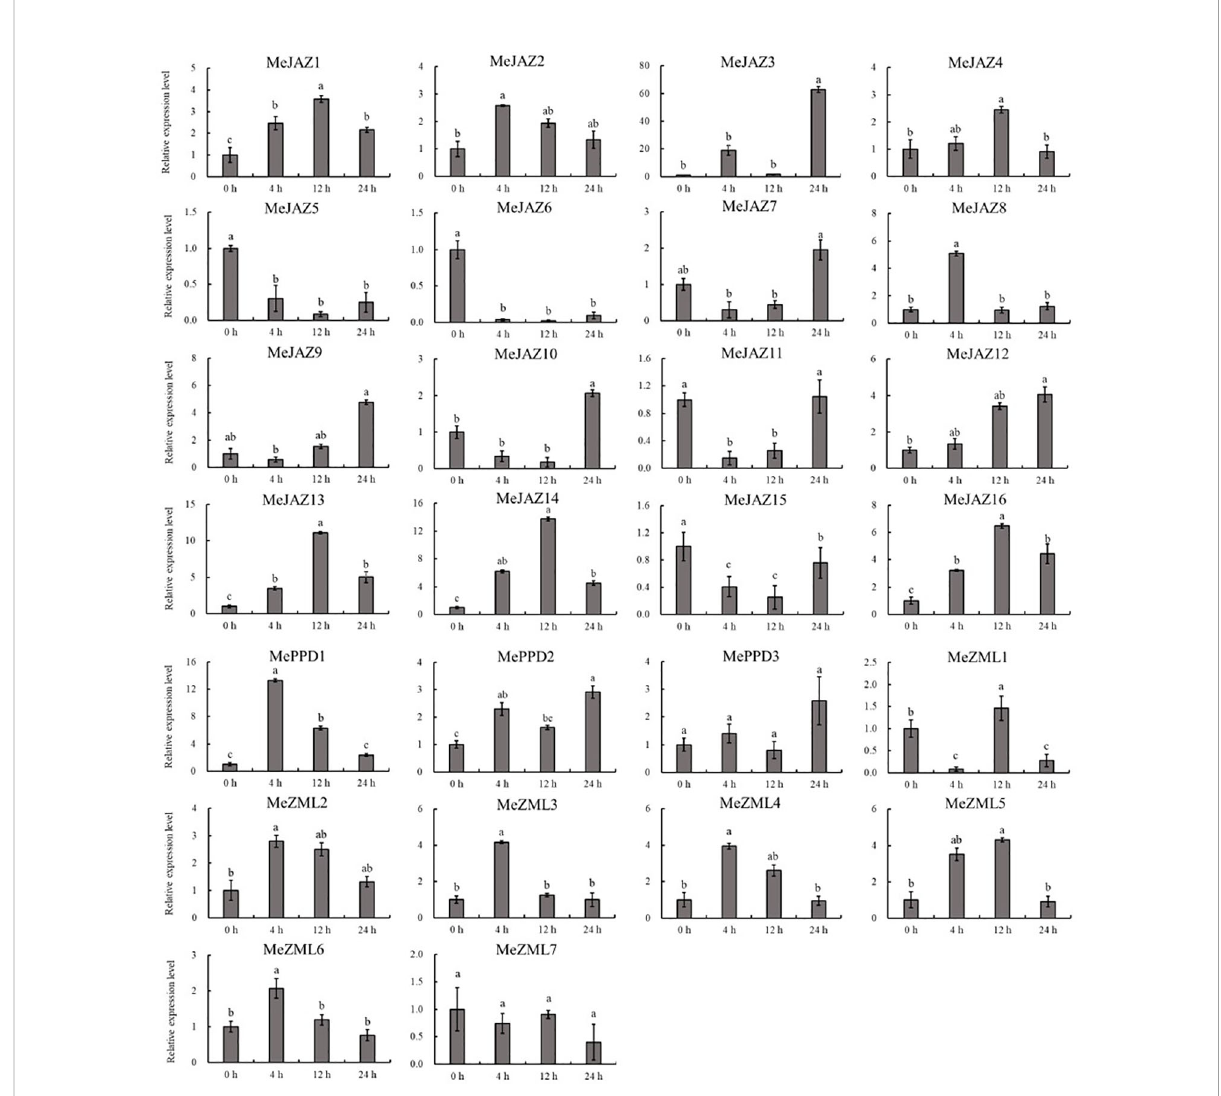
FIGURE 10 Expression pro fi les of 26 ZML , PPD and JAZ genes in response to cadmium stress in cassava as determined by qRT-PCR. The error bars represent the standard error of the means of three independent replicates. Values denoted by the same letter did not differ signi fi cantly at P < 0.05 according to Duncan ’ s multiple range